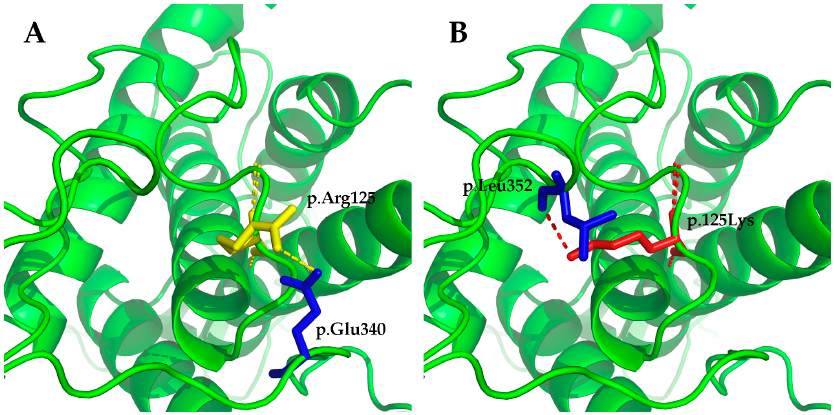
Figure 7. Structural modeling results of the wild-type Wnt family member 10A (WNT10A) protein and the p.Arg125Lys-mutated WNT10A protein. ( A ) There was a hydrogen bond between p.Arg125 and p.Glu340 in the wild-type WNT10A protein. ( B ) The original hydrogen bond vanished in the p.Arg125Lys-mutated WNT10A protein, and a new hydrogen bond between p.125Lys and p.Leu352 arose. The changes may lead to instability of the structure and affect the affinity to the receptor of WNT10A.